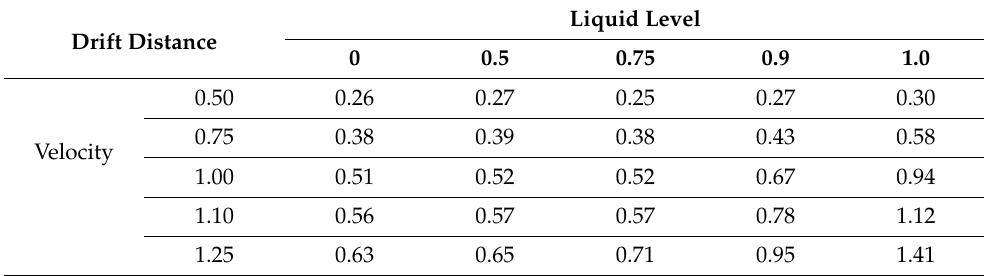
Table 3. System identification data table of drift distance. Liquid Level Drift Distance 0 0.5 0.75 0.9 1.0 0.50 0.26 0.27 Velocity